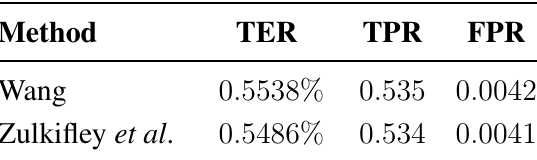
Table 7. Performance comparison between Wang’s method and Zulkifley et al . algorithm.